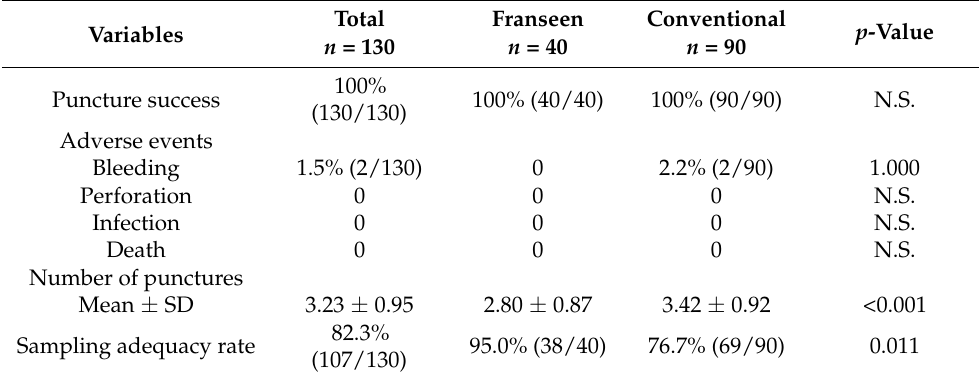
Table 3. Comparison of technical EUS-FNA outcomes for SELs ( n = 130). Total Franseen Conventional Variables